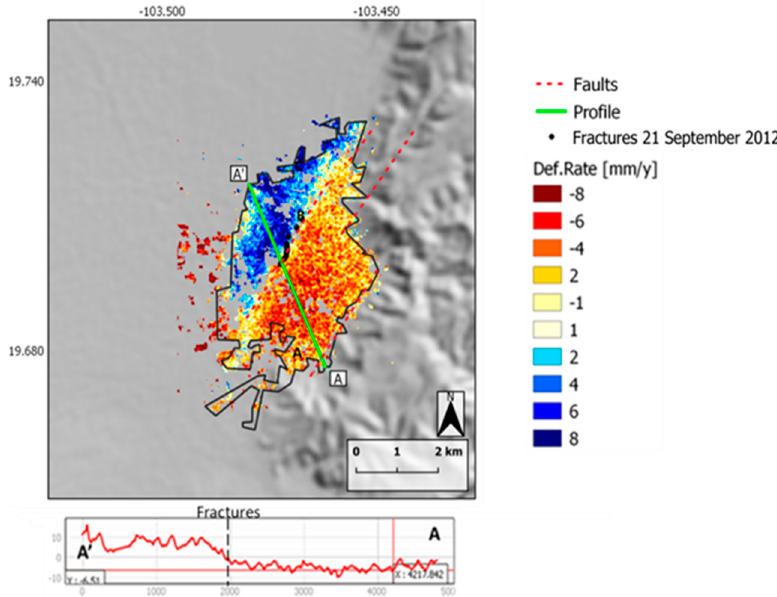
Figure 10. East-West deformation rate retrieved from S1 ascending and descending data. In the A-A’ velocity profile, the horizontal axis gives the distances (m), the vertical axis the velocities (mm/yr): the negative velocity values identify the subsidence area.